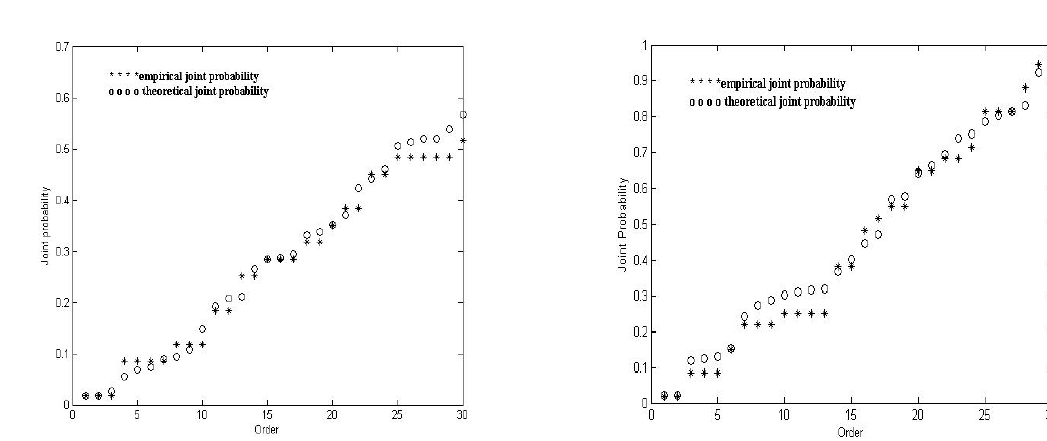
Fig. 2. Comparison of empirical and theoretical joint Fig. 5. Comparison of empirical and theoretical joint probability probability of the AMFOD and AMFM of Sanmenxia of the ARs of Sanmenxia and Huayuankou stations station